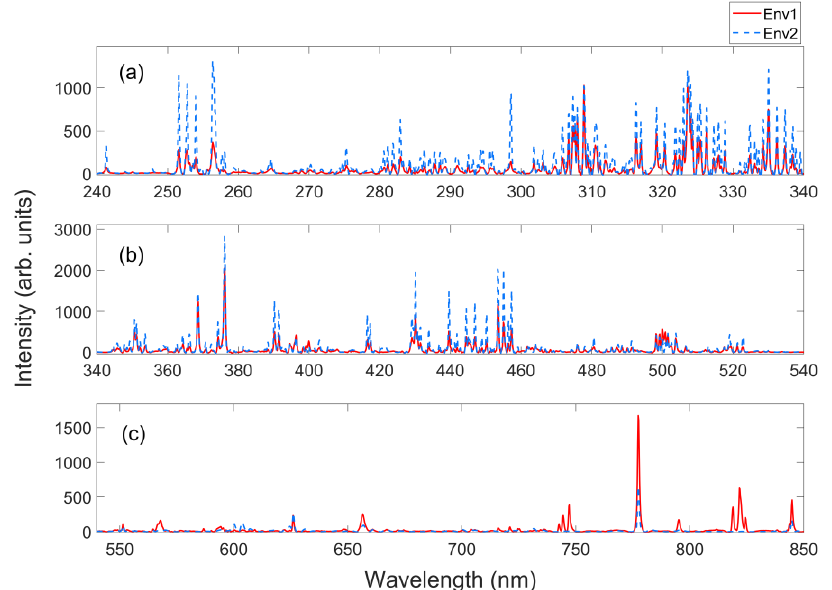
Figure 9. The LIBS spectra acquired from the Ti alloy reference sample in two different atmospheric environments. The red lines represent the result for environment 1 (Env1), and the blue dashed lines for environment 2 (Env2). ( a ) The spectra in Channel 1. ( b ) The spectra in Channel 2. ( c ) The spectra in Channel 3.